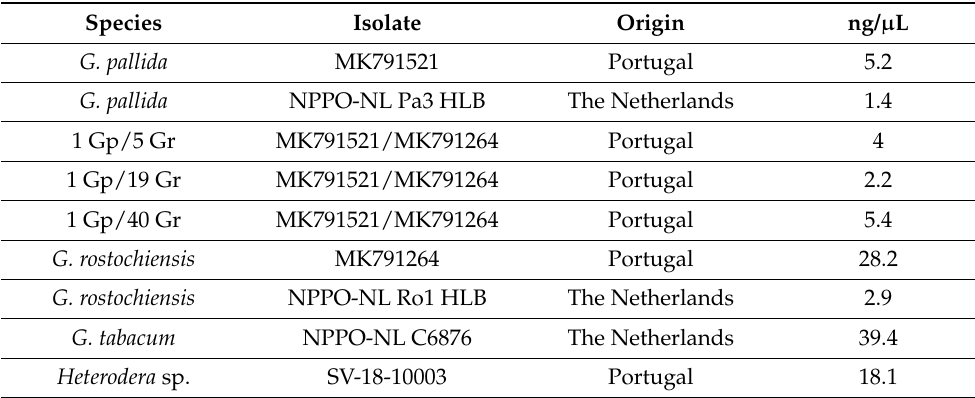
Table 1. Samples from Portugal and The Netherlands used for on-chip